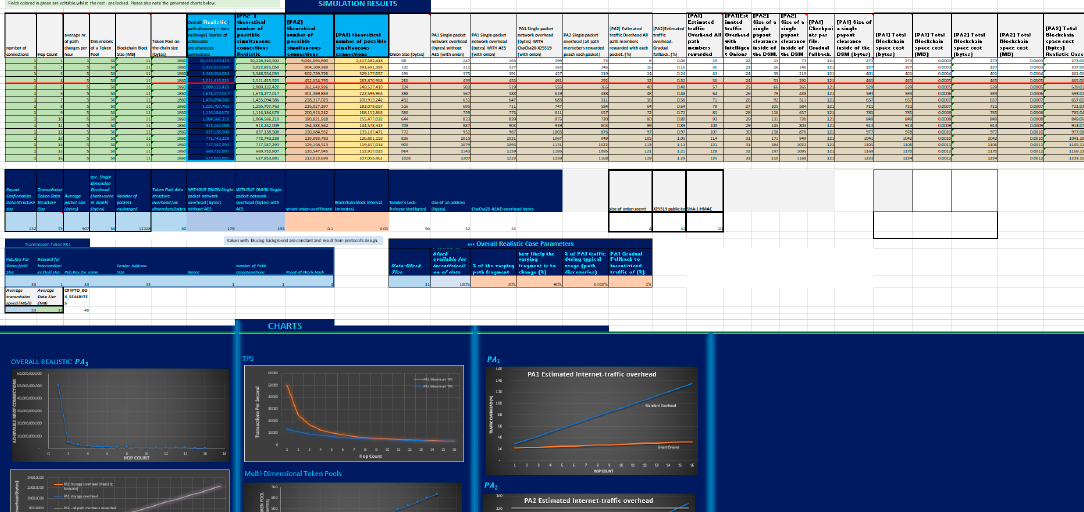
Figure 21. Fragment of a dedicated, Excel-based simulator of State-Channels and data incentivization performance under various parameters and conditions.